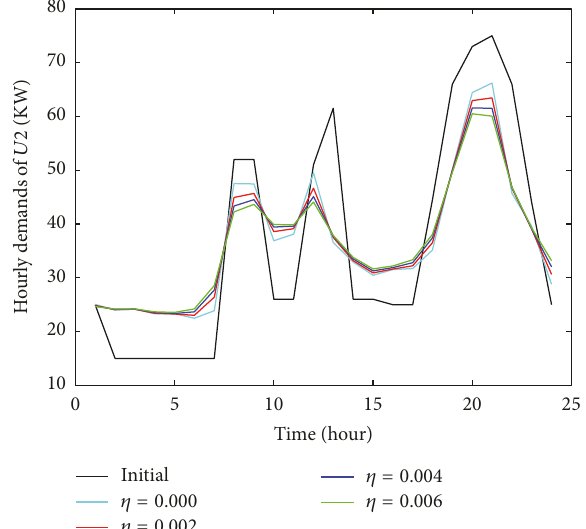
Figure 9: The effect of 𝜂 on optimal hourly demands of U